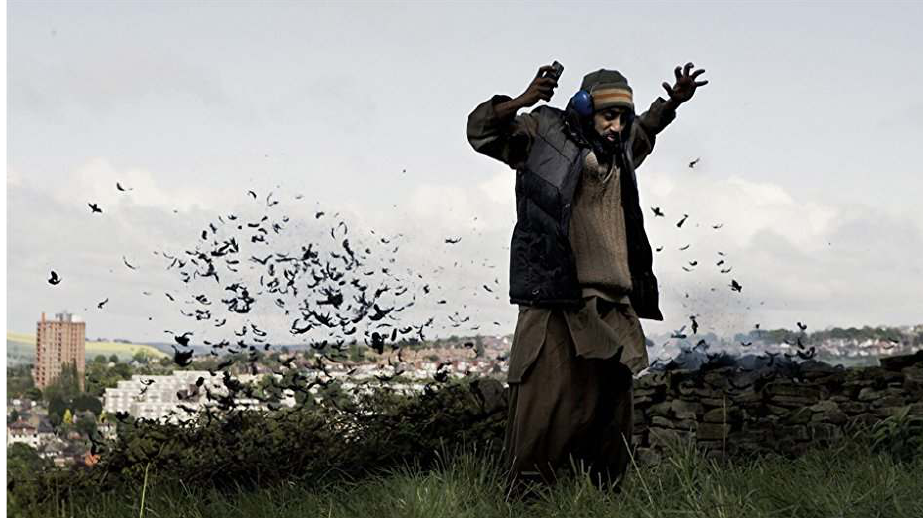
Figure 6. Faisal (Adeel Akhtar) tries to train crows to become suicide